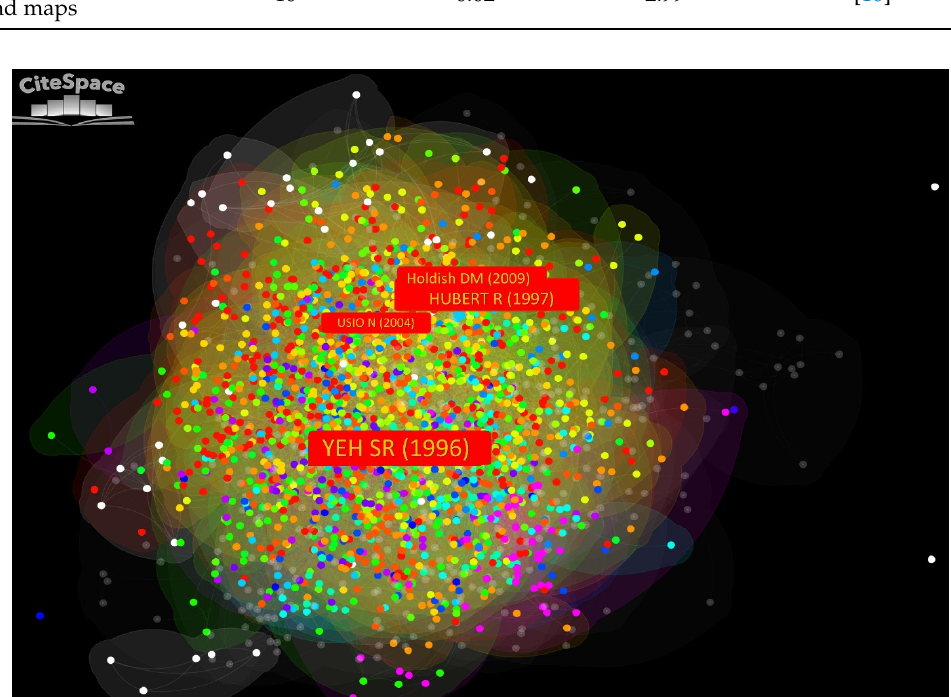
Figure 6. Document citation analysis, showing the overall article availability network (Holdich, D. 2019 [8], Yeh, S.-R. 1996 [47], Huber, R. 1997 [48], Usio, N. [49]).